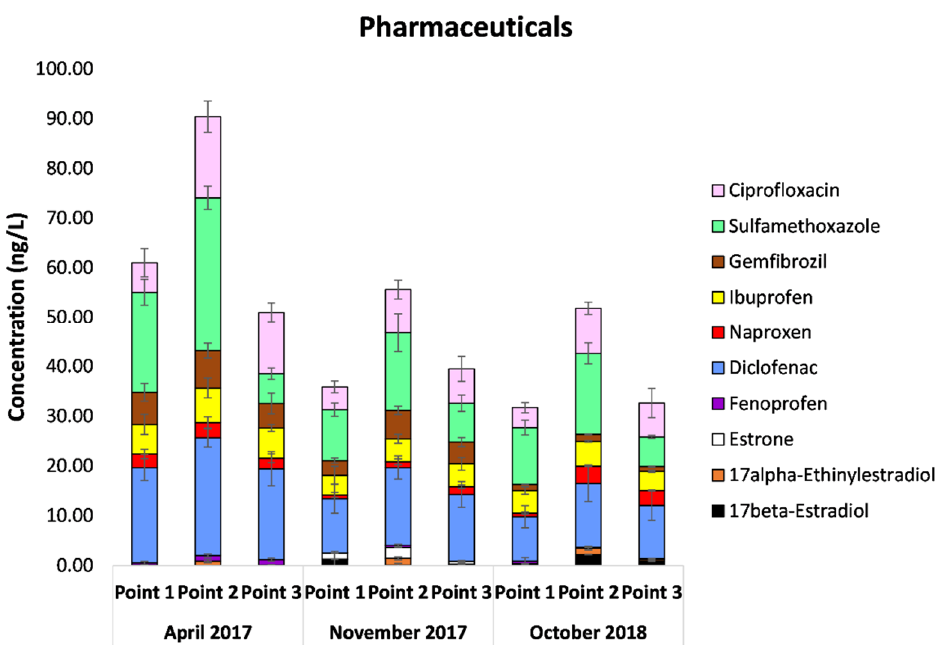
Figure 2. Concentration values (ng/L) for the eight pharmaceuticals and two antibiotics measured at the three sampling points (1, 2 and 3) during the three sampling times.